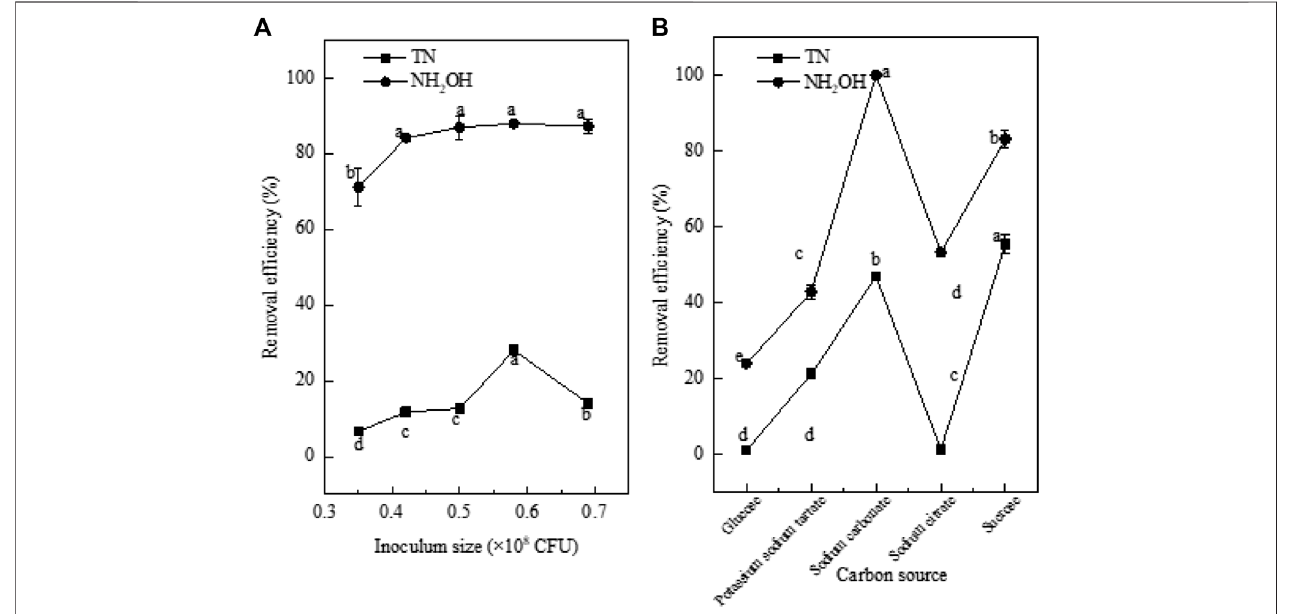
FIGURE4| EffectoffactorsonhydroxylamineremovalabilityofstrainEM-A1.Inoculumsize (A) ,carbonsource (B) .Valuesarepresentedasthemeans ± SDofthe results of three replicates (error bars). Different letters indicate signi fi cant differences between treatments at p < 0.05.